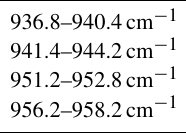
Table 6. Spectral regions used for the line-of-sight and temperature retrievals (at 0.2cm − 1